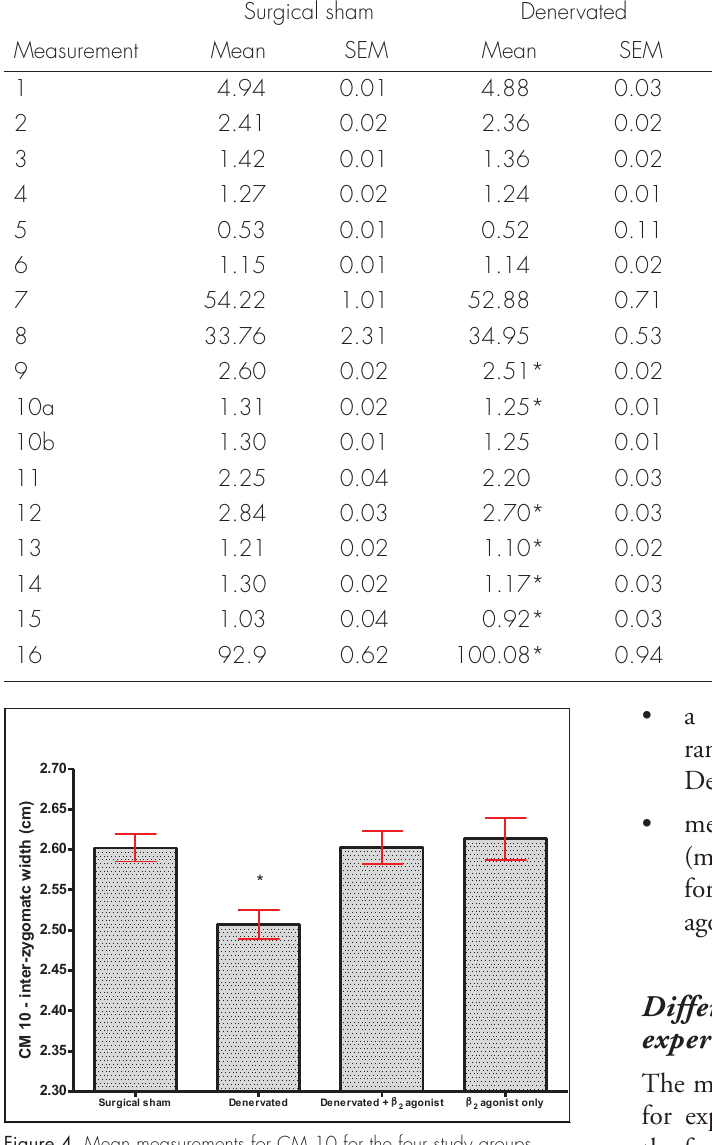
Figure 4. Mean measurements for CM 10 for the four study groups. Total inter-zygomatic width. * p < 0.05 = significant difference compared to Surgical